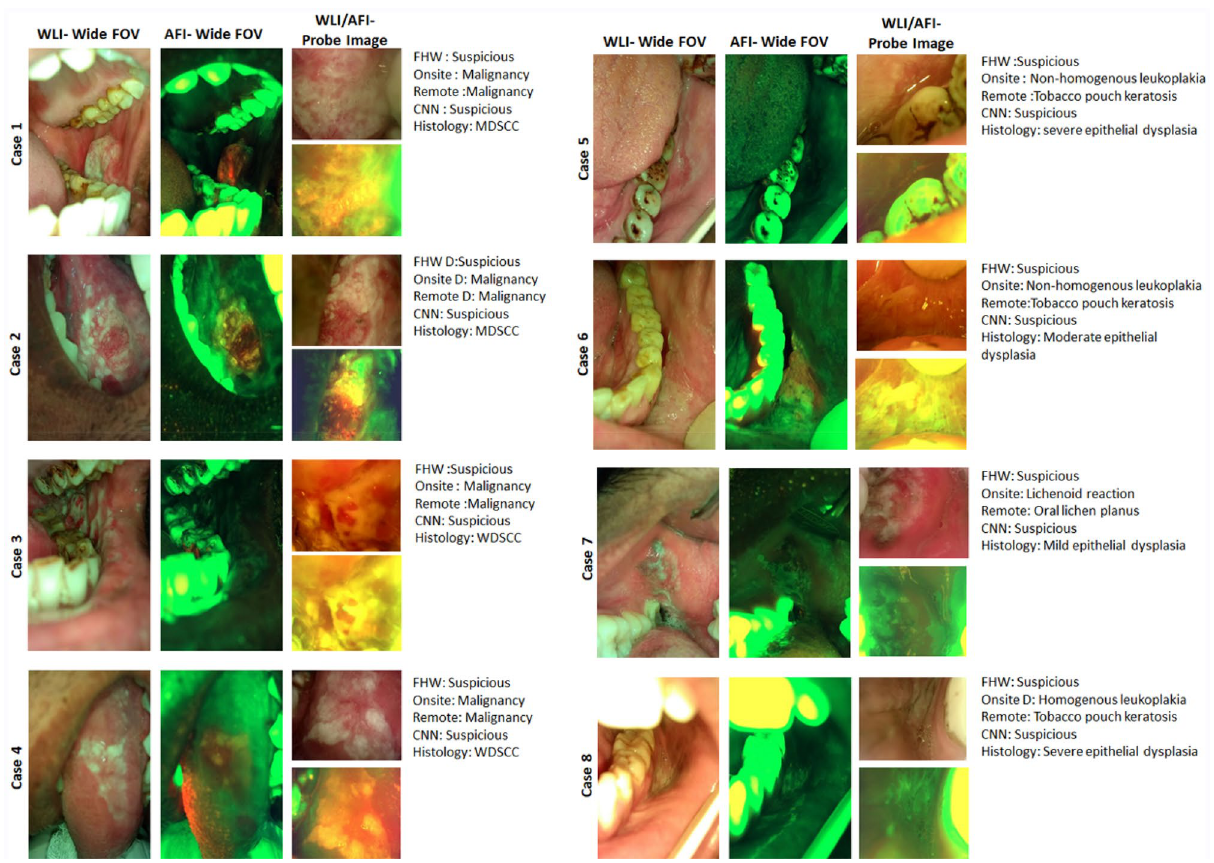
Figure 6. Dual-mode images and diagnosis. The dual-mode imaging device recorded WLI/AFI of the wide field of view (FOV) using a phone camera and focused probe image. The figures depict the diagnosis of FHWs, onsite specialists, remote specialists, CNN (MobileNet), and histology diagnosis of cases. WLI White Light Imaging, AFI Auto-fluorescence Imaging, FHW Front-Line-Health Worker, WDSCC Well-differentiated Squamous Cell Carcinoma, MDSCC moderately differentiated squamous cell carcinoma, CNN Convolutional Neural